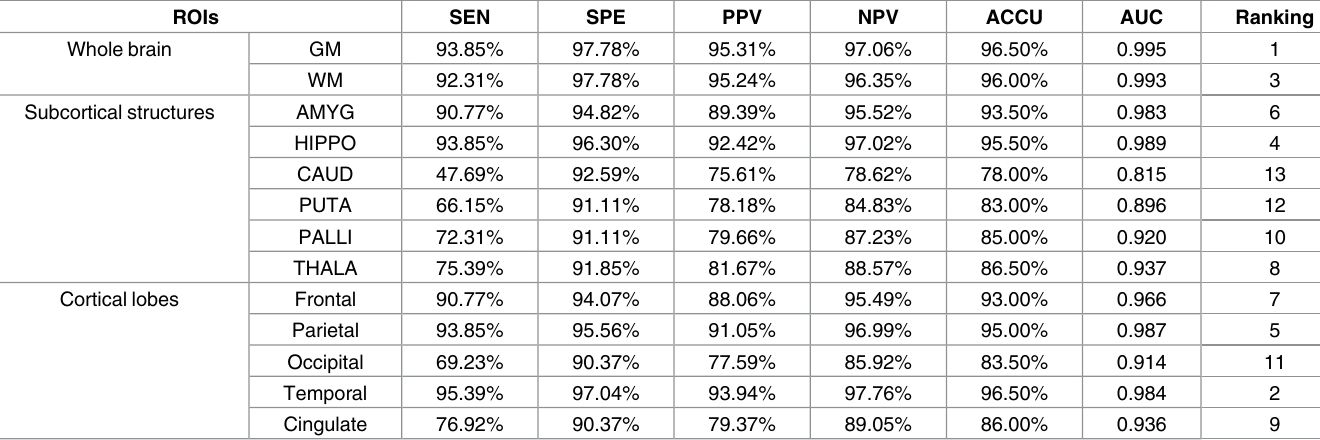
Table 2. Classification results of normal elderly controls vs AD.